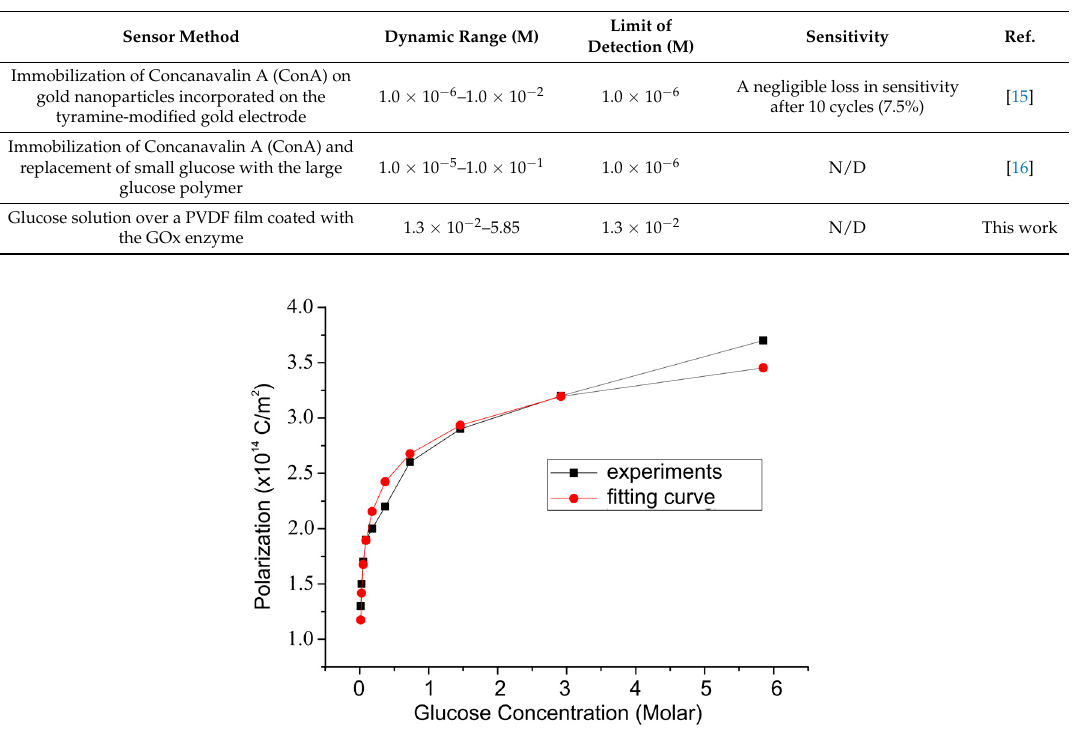
Figure 7. The change in PVDF film polarization versus glucose concentration with an enzyme concentration of 2,500,000 units/L.